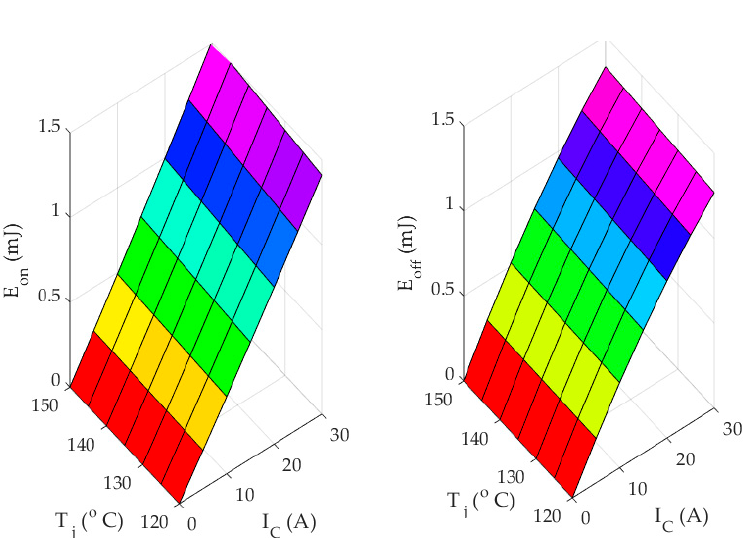
and off E for different collector currents and junction temperatures. Figure 6. Interpolation of E on and E of f for different collector currents and junction Figure 6. Interpolation of on E